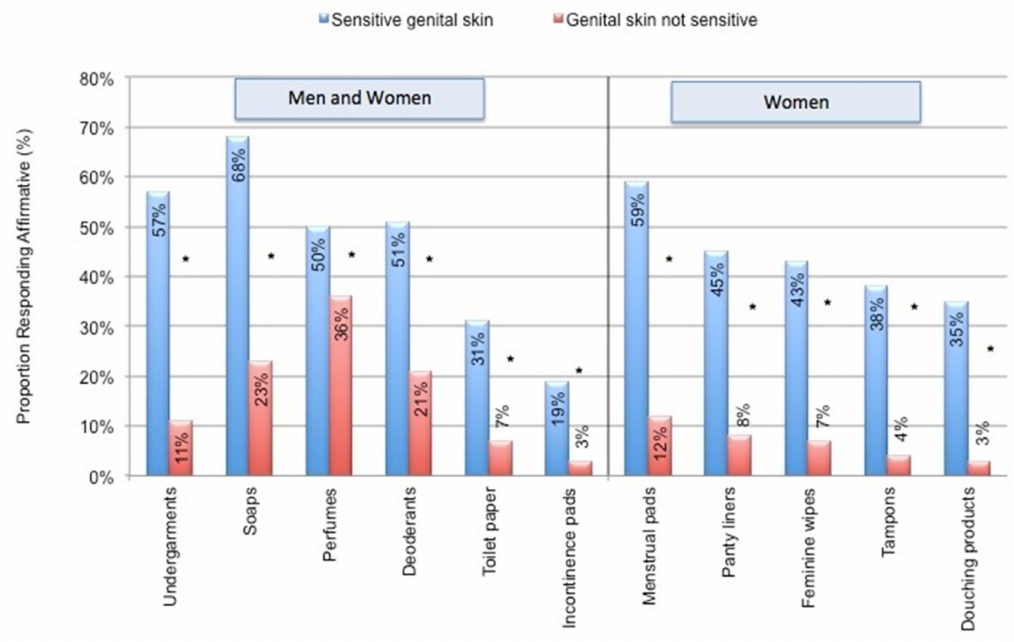
Figure 5. Products used in the genital area reported to trigger SSS symptoms. Responders in the Cincinnati study were asked if they had some degree of genital sensitivity, and whether or not specific categories of products used in the genital area triggered the unpleasant sensations of SSS at that body site (adapted from [81]). Out of the 1039 test population, 577 declared some degree of sensitive genital skin. Among the 869 women in the study, 505 declared some degree of sensitive genital skin. (* = p <